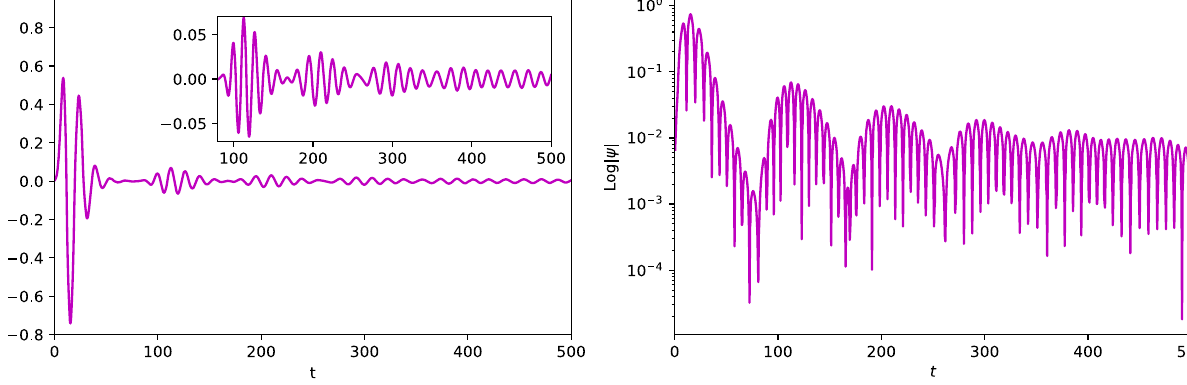
Fig. 11 The GWs echoes of electromagnetic field perturbation (left panel) and semilogarithmic plots for the GWs echoes of electromagnetic field (right panel) to black bounces in a cloud of strings with M = 0 . 5 , l = 1 , L = 0 . 1 , a = 1 .